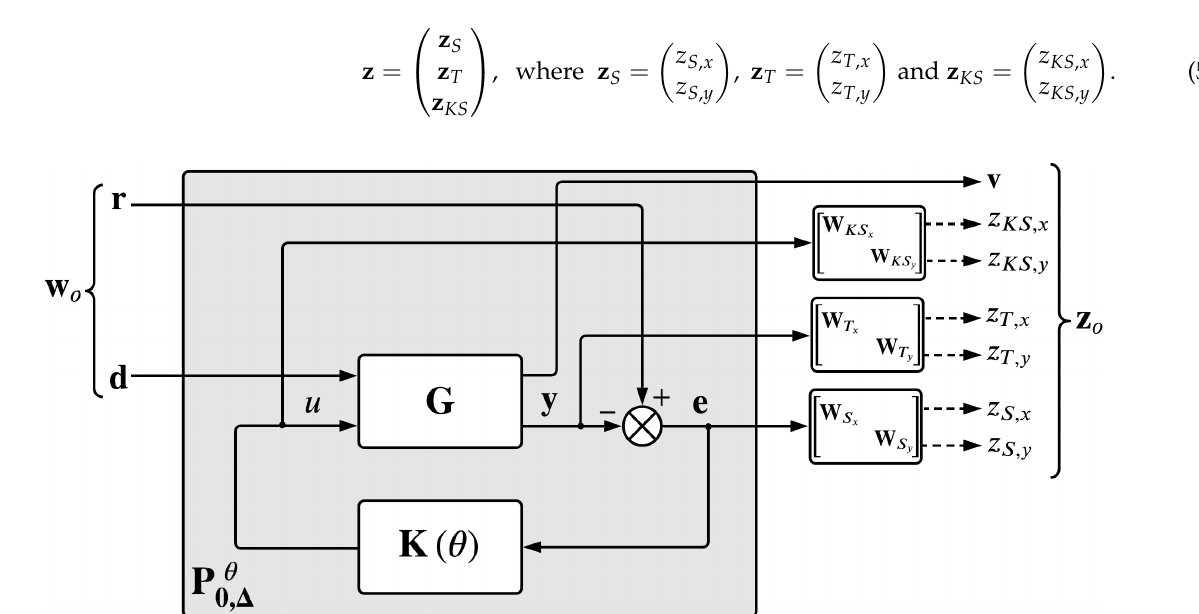
Figure 3. Closed-loop augmented